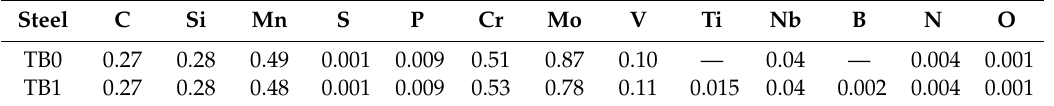
Table 1. Chemical composition of the investigated materials